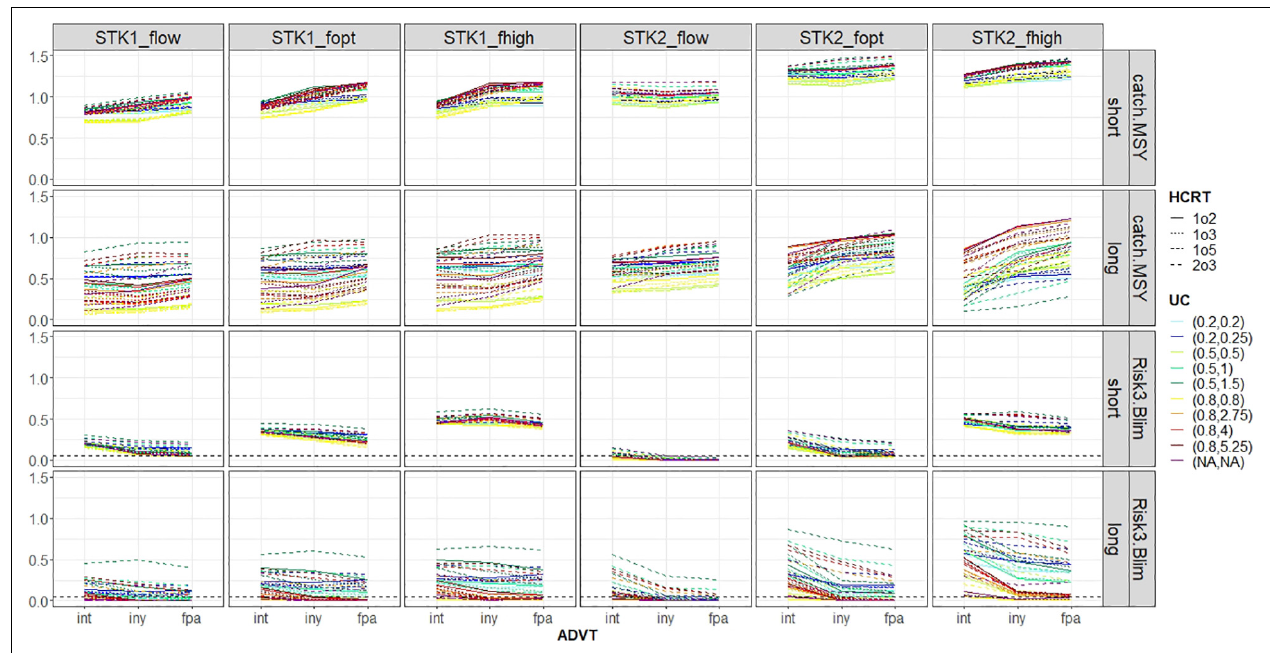
FIGURE 3 | Relative yields (catch/MSY) and biological risks (Risk3.Blim: maximum probability of falling below B lim ) by calendar type (ADVT, x-axis) and alternative operating models (in columns). The harvest control rules (HCRT) are represented by line types and uncertainty caps limits (UC) by line colours. See Table 1 for definitions of abbreviations. The horizontal black dashed line represents the 0.05 biological risk. Interactive version of the figure is available online at